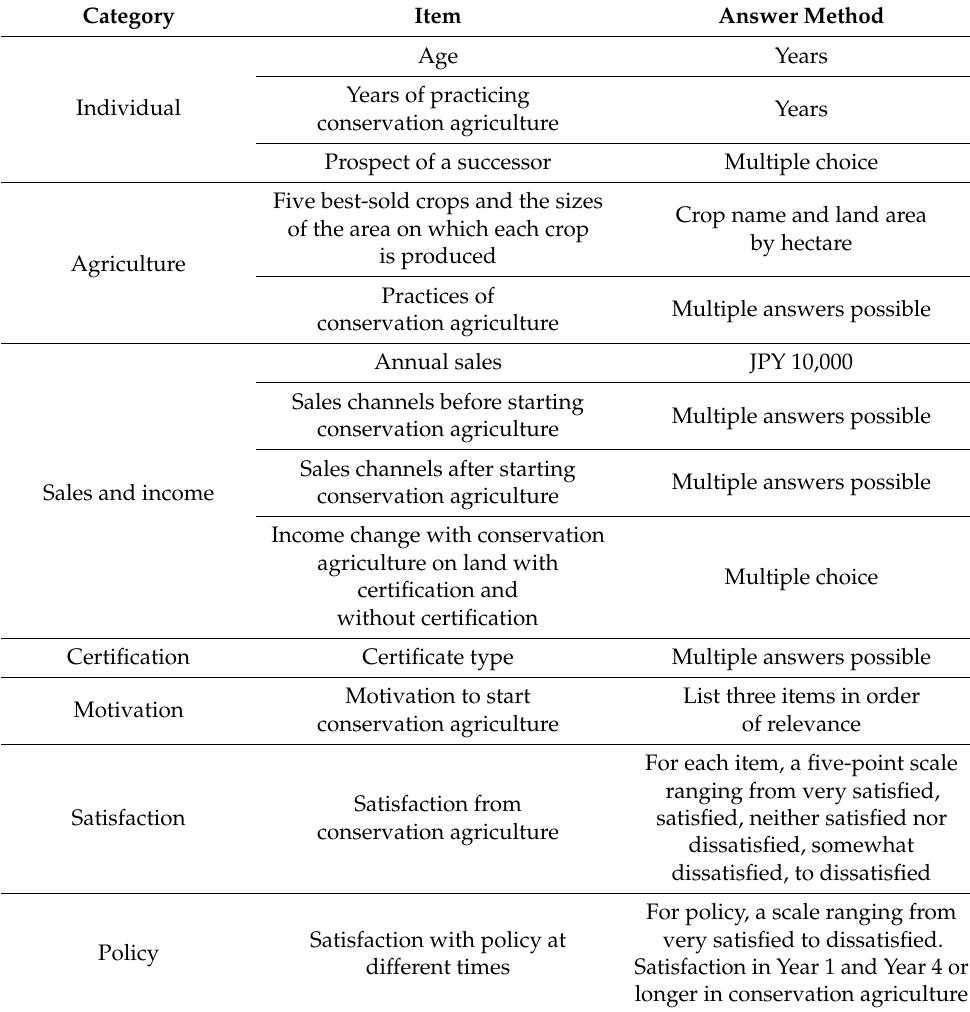
Table 1. Ishikawa Prefecture conservation agriculture questionnaire